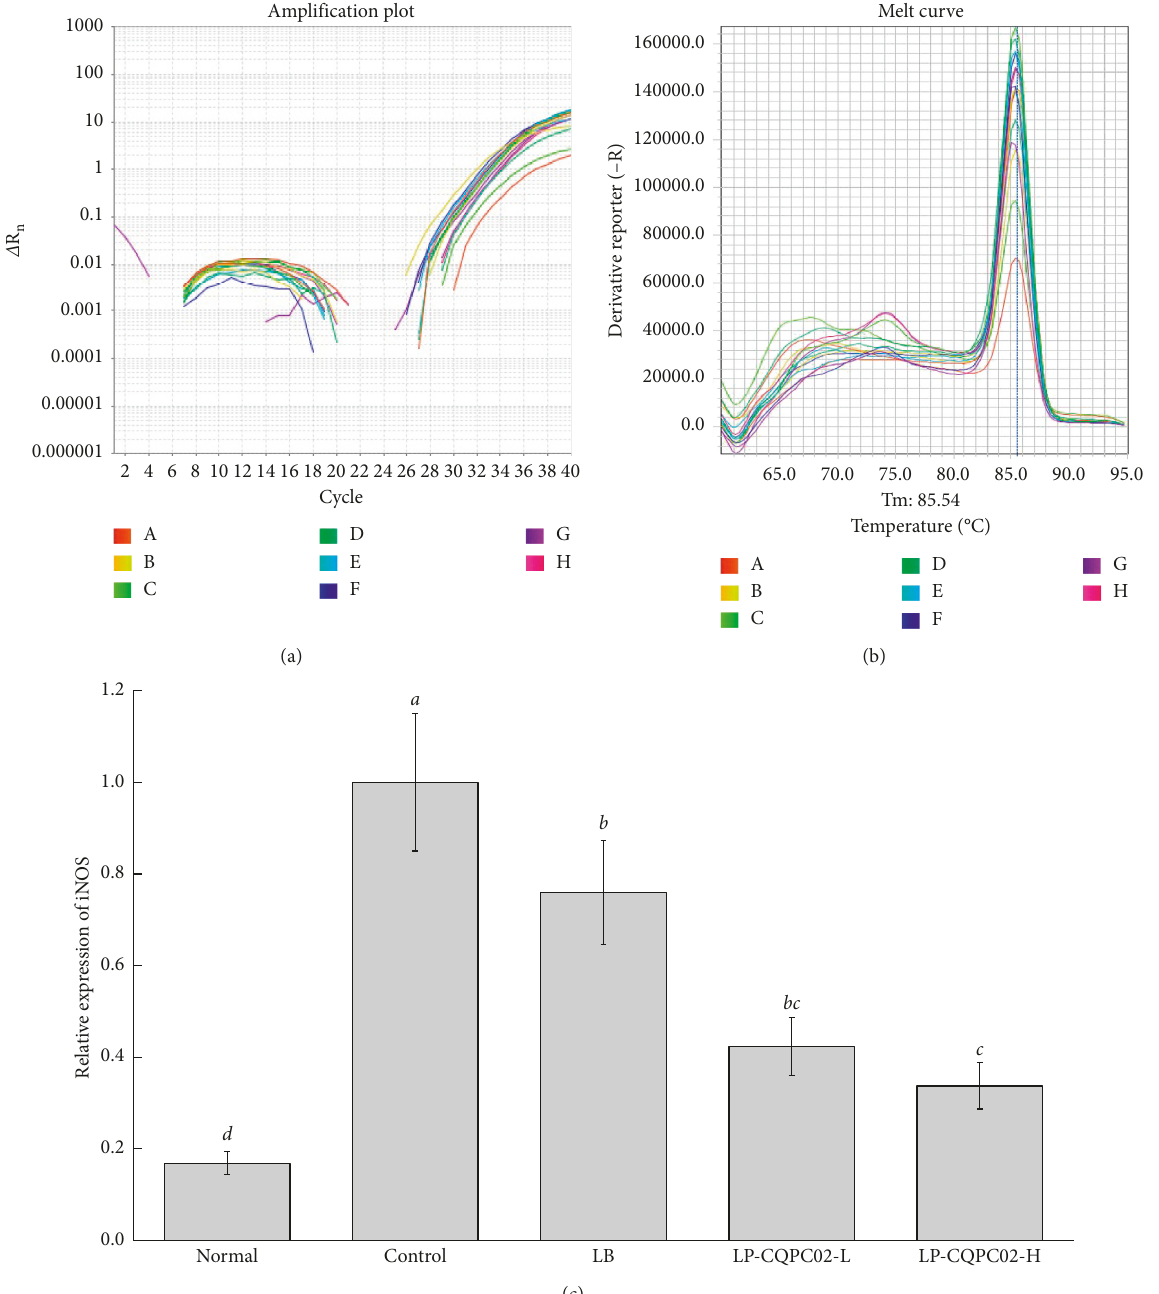
Figure 8: The mRNA expression level of iNOS in the small intestine tissue of mice. (a) Amplification curve, (b) dissolution curve, and (c) relative expression. The values presented are the mean ± standard deviation. a–d The mean values with different letters in the same bars are significantly different ( p < 0.05) according to Duncan’s multiple-range test; there was no significant difference in the same letter repre- sentation between the two bars ( p > 0.05), but there was significant difference in the different letter representation ( p < 0.05). LB: Lactobacillus delbrueckii subsp. bulgaricus (1.0 × 10 9 CFU/kg b.w. gavage); LP-CQPC02-L: Lactobacillus plantarum CQPC02 (1.0 × 10 8 CFU/kg b.w. gavage); and LP-CQPC02-H: Lactobacillus plantarum CQPC02 (1.0 × 10 9 CFU/kg b.w.